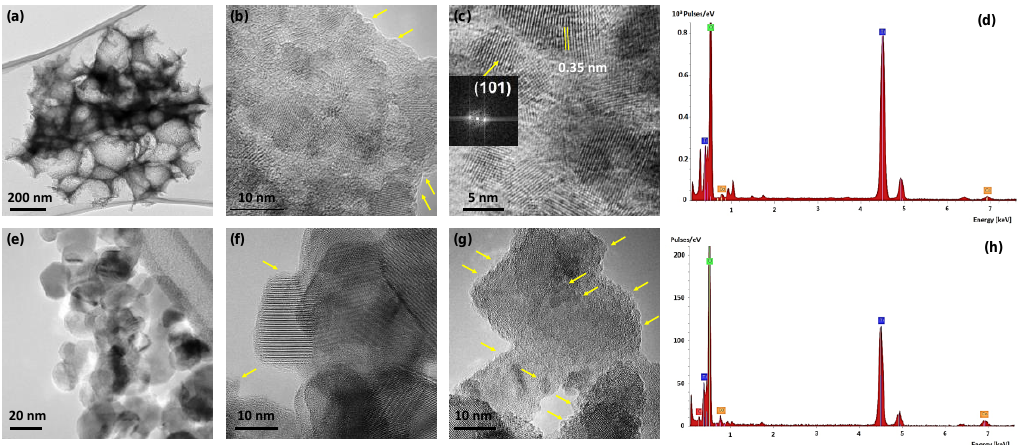
Figure 2. TEM images at different magnifications for the ( a – c ) CoO x -PC406 and ( e – h ) CoO x -P25 films. ( d , h ) Energy-dispersive X-ray (EDX) spectra corresponding to the areas of the TEM images of ( b ) and ( f ).